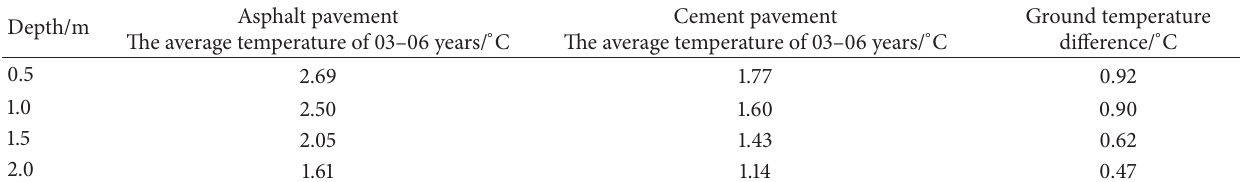
Table 2: Comparisons of the ground temperature at the depth of 2.0 under pavement. Depth/m